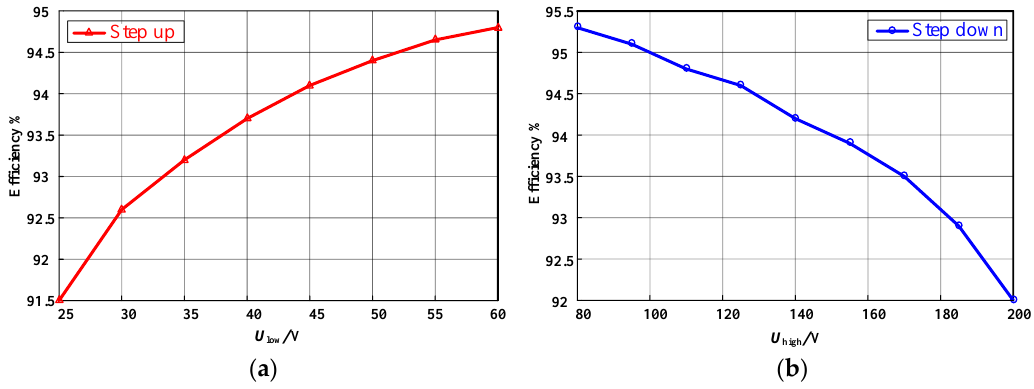
Figure 22. Efficiencies with different input voltages; ( a ) Step-up mode; ( b ) Step-down mode.